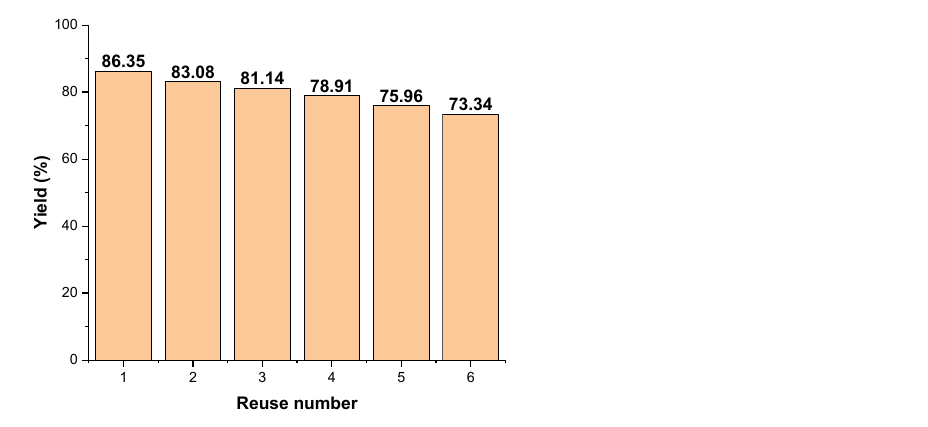
Figure 14. Reuse of BN-Ag 0 catalyst in the catalytic destruction of industrial pollutant MG (20 mL). Destruction conditions: concentration MB = 5 × 10 − 5 M, mass of catalyst 2.5 mg, 0.5 g · h − 1 O 3 , ozonation time 300 s.